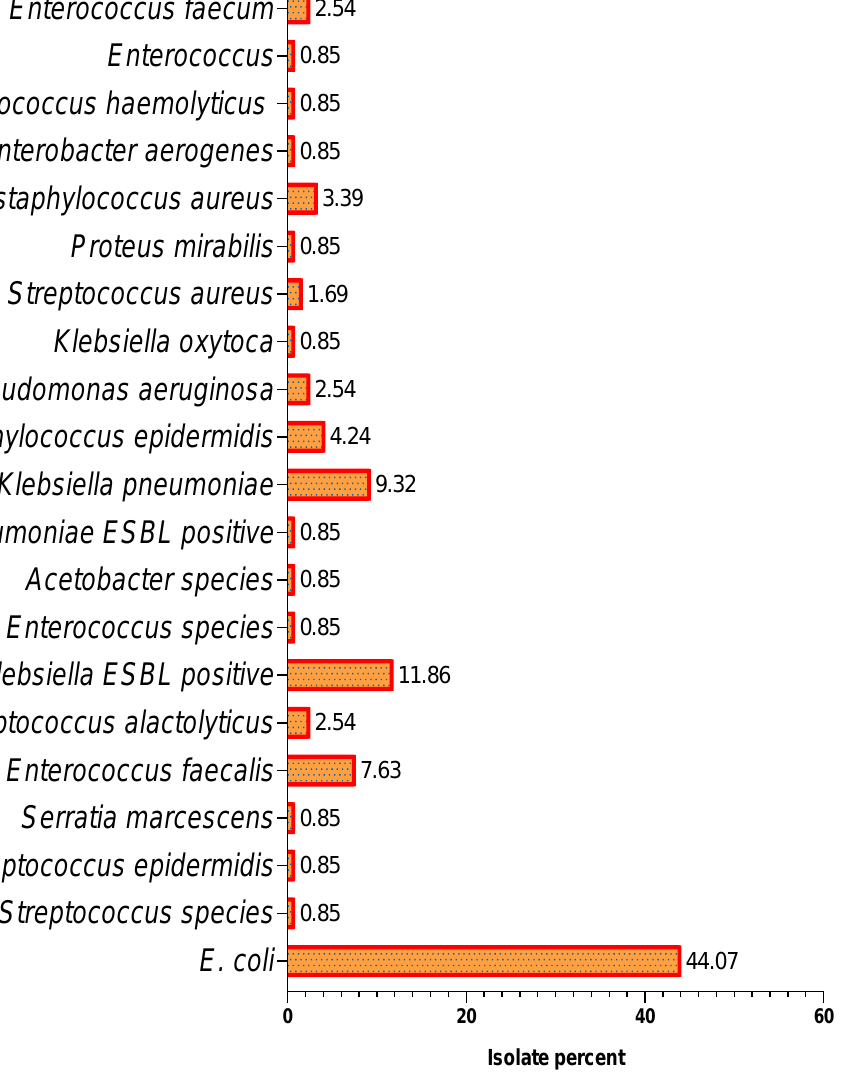
Figure 1. Percent of uropathogens from May 2017 to April 2018. Note: Total 118 uropathogen isolates were identified between May 2017 and April 2018; among them, four major UTI-causing bacteria were identified as E. coli = 52; ESBL-positive E. coli = 14; K. pneumoniae = 11; E. faecalis = 9.